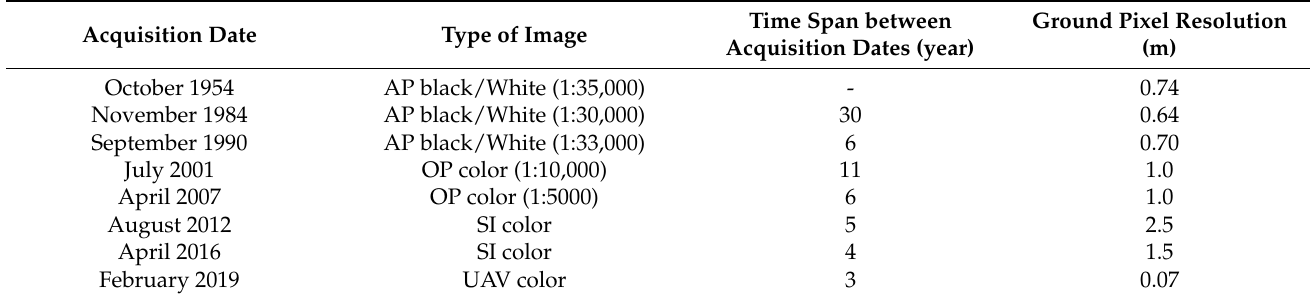
Table 1. Characteristics of the images used in this study (AP = aerial photograph; OP = orthophoto; SI = satellite image; UAV = unmanned aerial